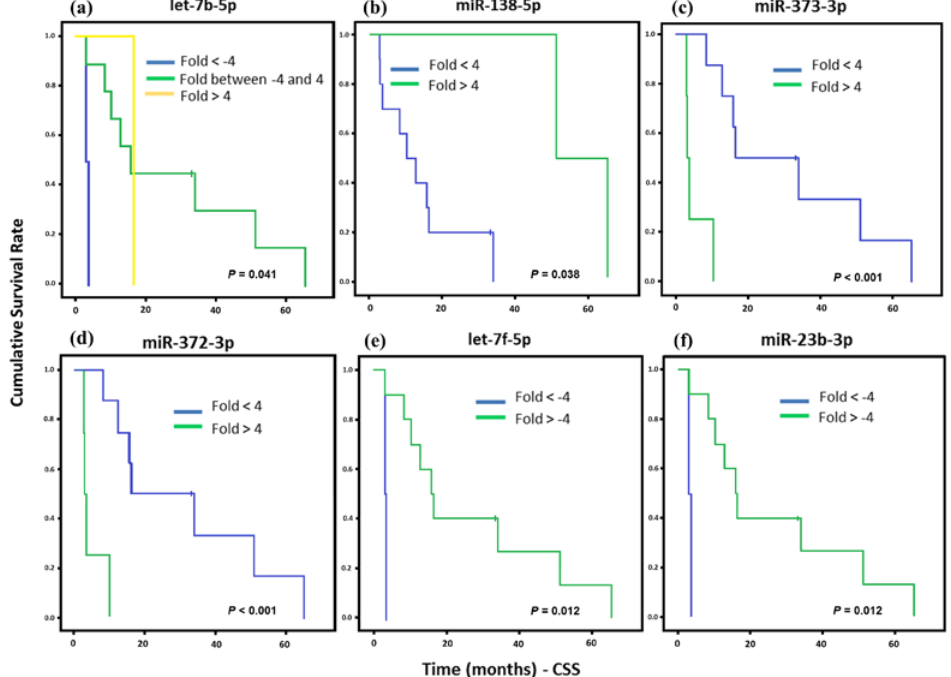
Figure 4. Kaplan Meier curves and estimates of CSS associated with miRNAs expression in high grade ESS (HG-ESS) patients ( n = 12). ( a ) let-7b-5p expression associated with CSS ( p = 0.041) both up and downregulation of this gene were associated to poorer prognosis. ( b ) Association of miR-138-5p expression with CSS ( p = 0.038). ( c , d ) miR-373-3p and miR-372-3p were highly associated with CSS ( p < 0.001). ( e , f ) let-7f-5p and miR-23b-3p expression were associated with CSS ( p = 0.012).